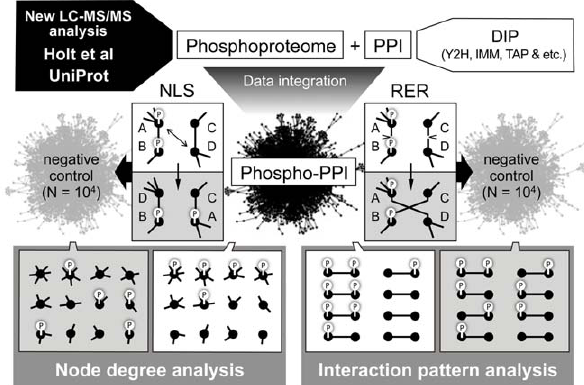
Figure 1. Overview of integrative analysis of yeast multi-omics data. New phosphoproteins were identified by LC-MS/MS analysis and